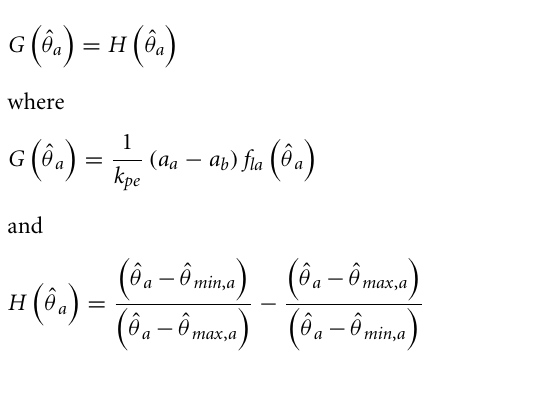
Substituting (12) and (13) into (11)